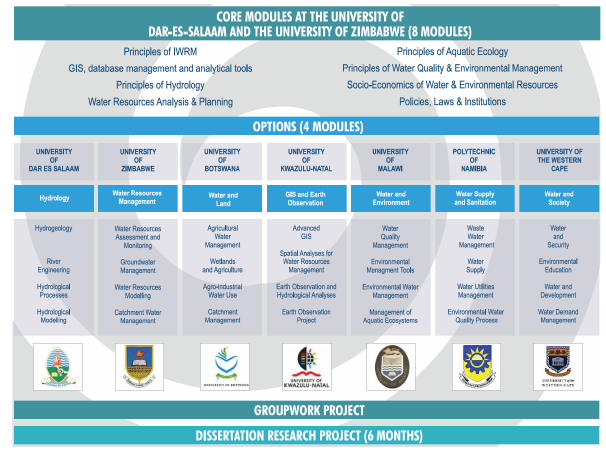
Fig. 2. New structure of the regional Master programme in IWRM, as at 2012.